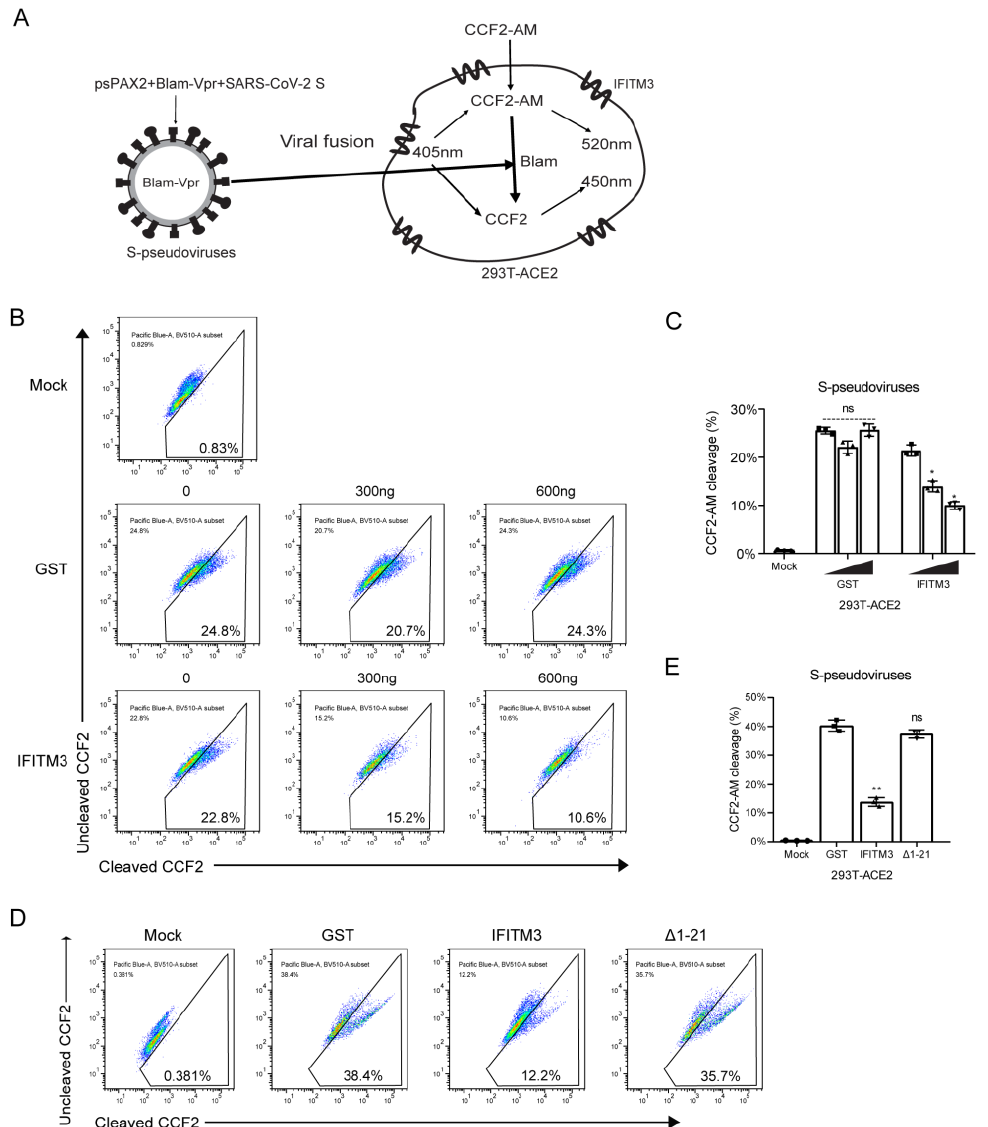
Figure 2. IFITM3 inhibits SARS-CoV-2 entry. ( A ) Illustration of the β -lactamase-Vpr